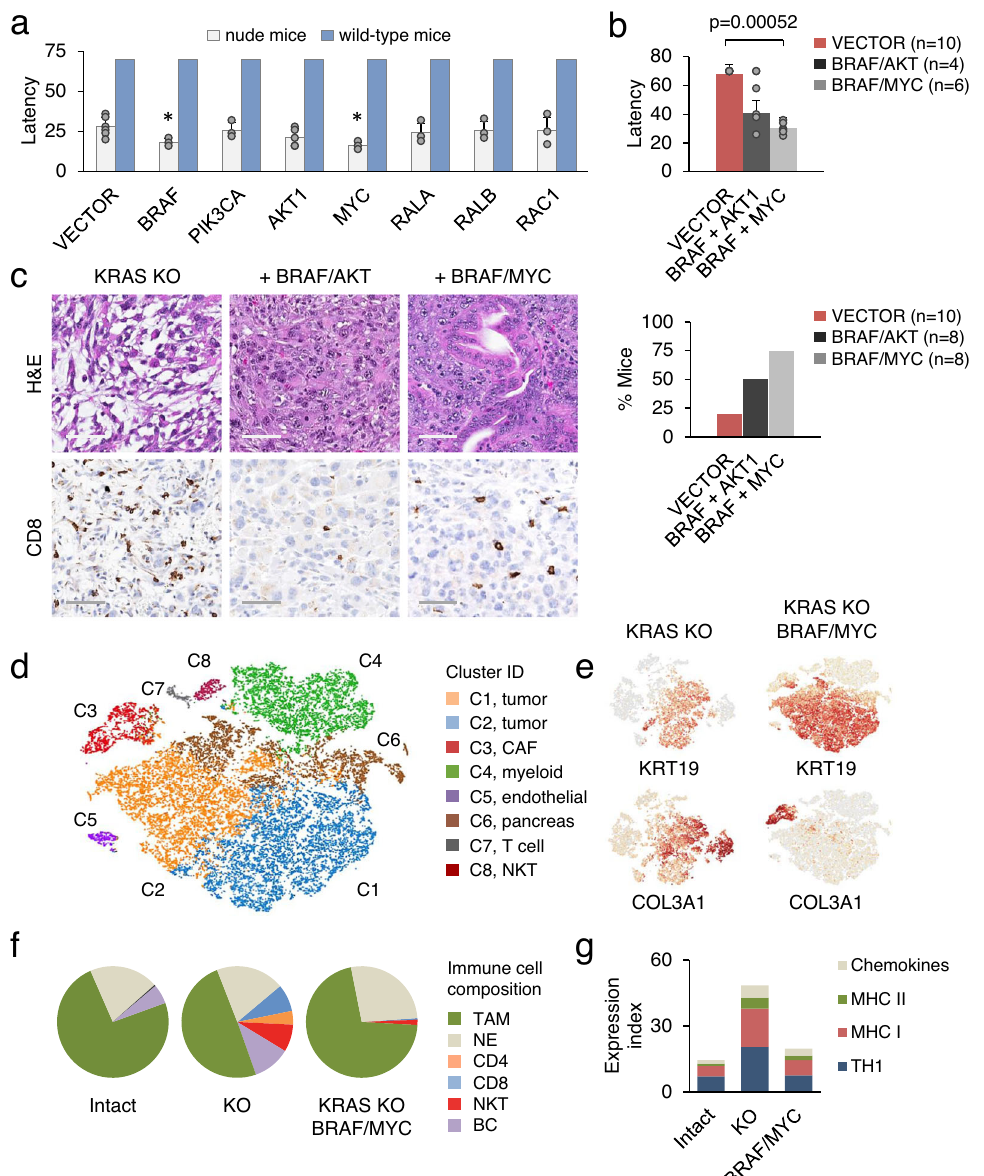
Fig. 5 BRAF and MYC partially rescue tumorigenesis of KRAS KO cells in immunocompetent mice. a Latency of tumor development in nude mice or wild-type mice by retrovirally transduced KRAS KO KPC cells relative to vector infected cells. Results are derived from three independent injections of each cell line. Non-tumor-bearing mice were terminated on day 70 post-implantation. Data are presented as mean ± SD. Signi fi cance was determined using two- tailed test at the 0.05 con fi dence interval. Asterisks indicate statistically signi fi cant differences ( p = 0.0365 for Braf and 0.017 for Myc , respectively). b The mean latency (top) and ef fi ciency (bottom) of tumor development by KRAS KO KPC cells transduced with the indicated genes. Data are expressed as mean ± SD. Signi fi cance was determined using two-tailed t -test at the 0.05 con fi dence interval. c Histology and IHC staining of representative tumors shown in ( a ). Scale bar 100 μ M. d Single-cell clustering of KRAS KO tumors reconstituted with Braf V600E and Myc T58A . The data represent 24 K pooled cells from two different tumors. e t-SNE plots showing expression of selected genes in KRAS KO KPC tumors before and after reconstitution with Braf V600E and Myc T58A . f Immune cell composition of KRAS intact and KRAS KO KPC tumors before and after reconstitution with Braf V600E and Myc T58A . g The mRNA expression levels of Th1, MHC I, MHC II, and chemokine genes ( Ccl5 , Cxcl9 , and Cxcl10 ) in KRAS intact and KRAS KO tumor cells before and after reconstitution with Braf V600E and Myc T58A (Fig. 5d). Source data are provided as a Source data fi